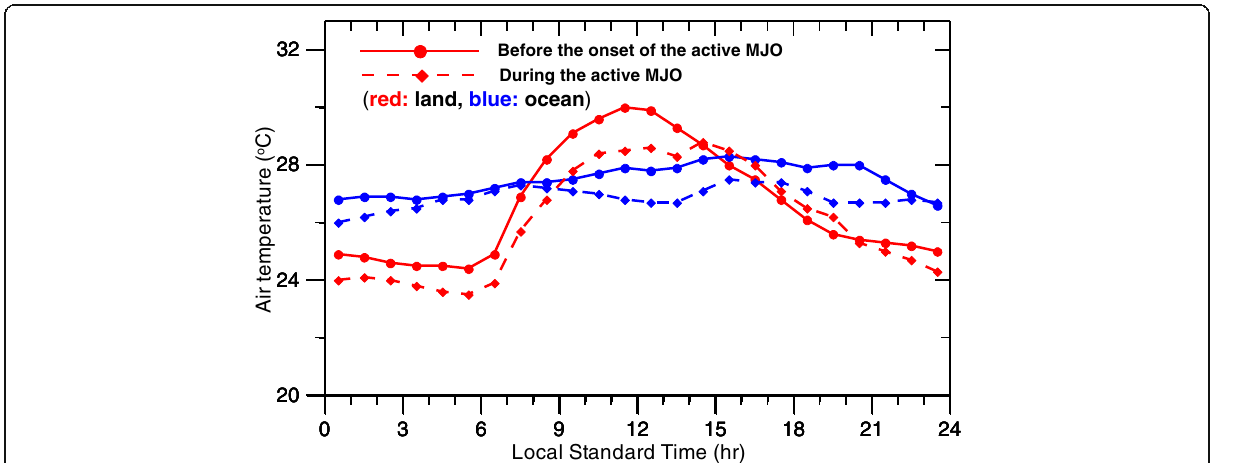
Fig. 6 A comparison between the diurnal changes in the hourly mean air temperature observed at Bengkulu on the western coast (red lines) and over the sea on the research vessel Mirai (blue lines), before the onset of the active MJO (solid lines) and averaged over 23 November to 12 December and during the active MJO (broken lines) averaged over 13 to 17 December